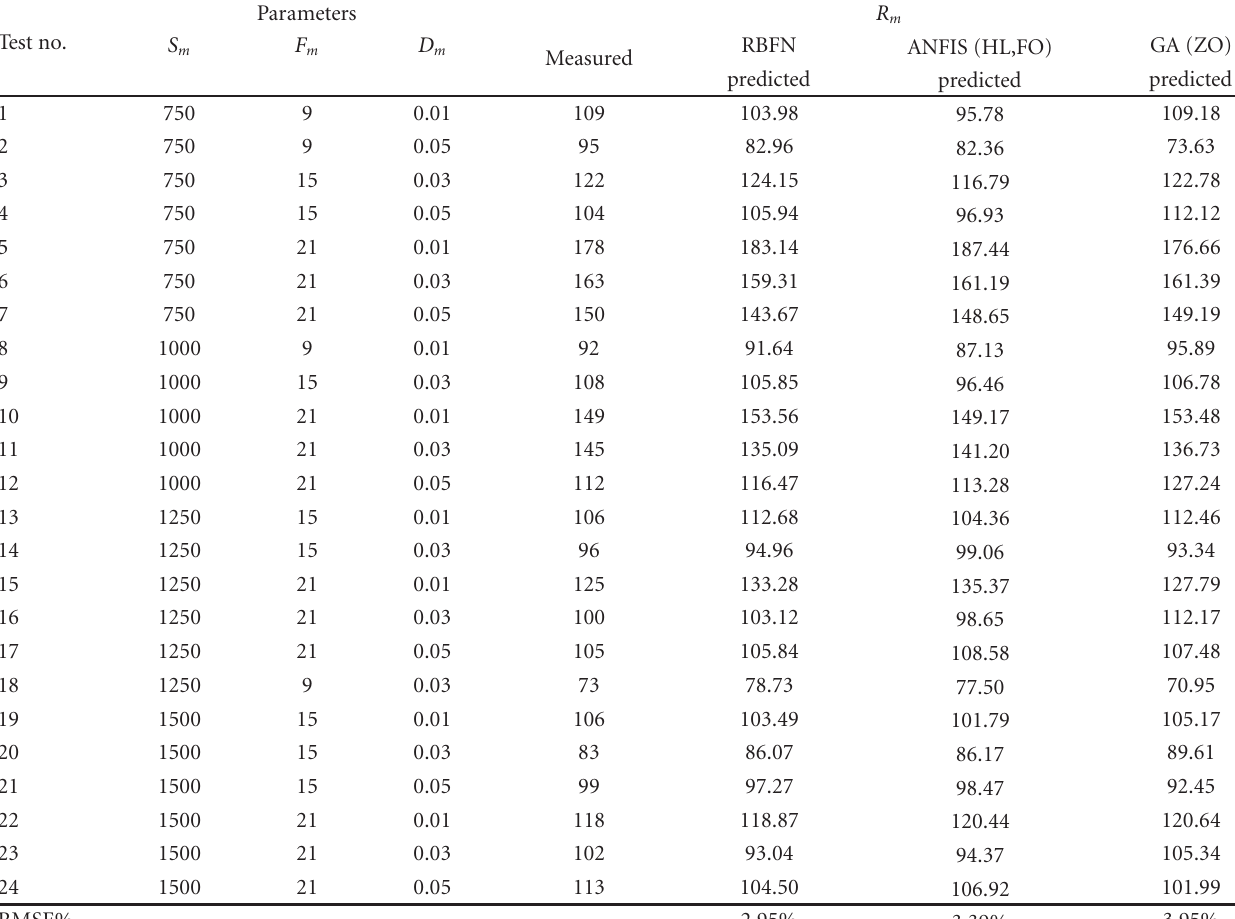
Table 6: A comparison of measured and predicted surface roughness of the test data.